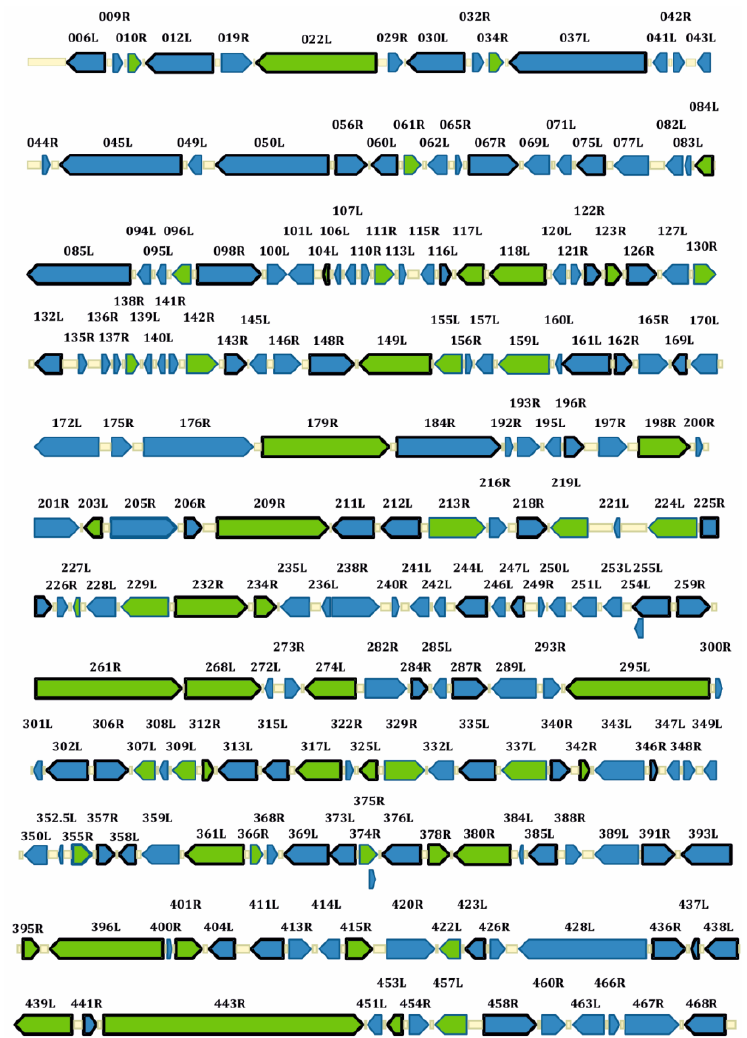
Figure 4. IIV-6 linear genomic map presenting virion and viral proteins identified in infected cells using mass spectrometry (genome size 212,482 bp). Arrows represent the transcriptional direction of the ORFs. All arrows with a black frame represent ORFs for which the corresponding protein was detected in the infected-cell proteomic analysis [127]. Green arrows represent known virion proteins [128]. This figure was published previously [127].